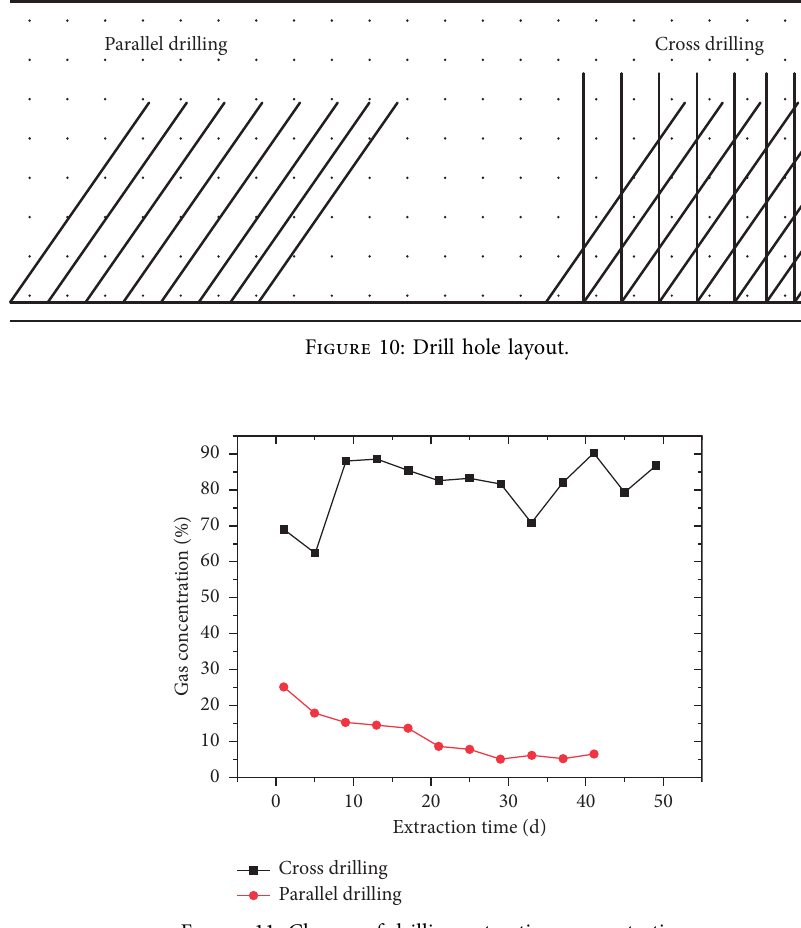
Figure 11: Change of drilling extraction concentration.